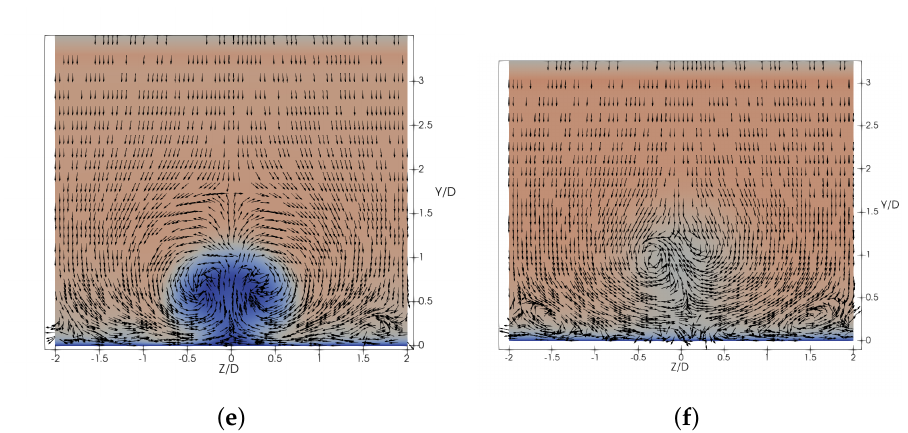
Figure 18. Iso-contours of the mean velocity magnitude with vector plots at different YZ planes, X / D = 2 and 7.5. ( a ) VR = 0.5 ZPG X / D = 2. ( b ) VR = 0.5 ZPG X / D = 7.5. ( c ) VR = 0.5 FPG X / D =